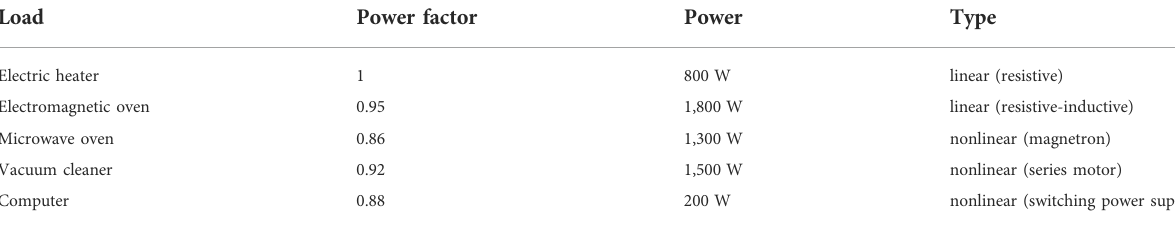
TABLE 1 Main parameters of loads for test.